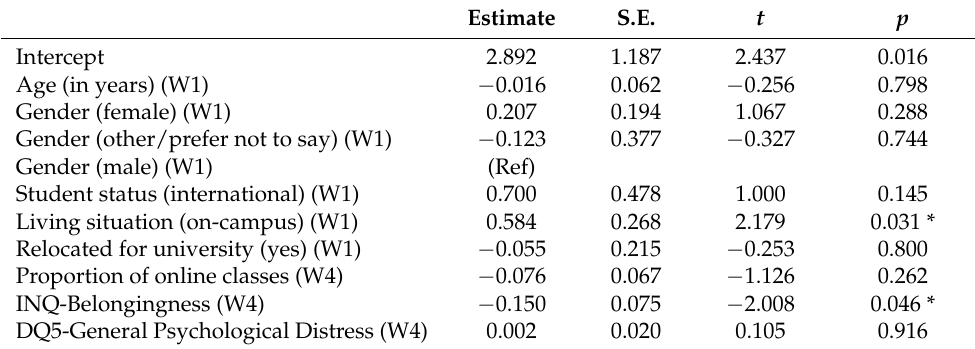
Table 2. Linear regression model for engagement in university life at Wave 4 ( N = 165).